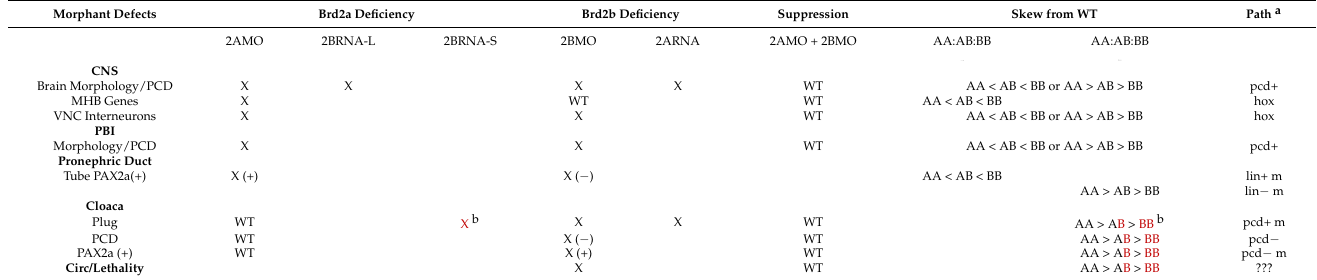
Table 3. Summary of paralog interaction with functional